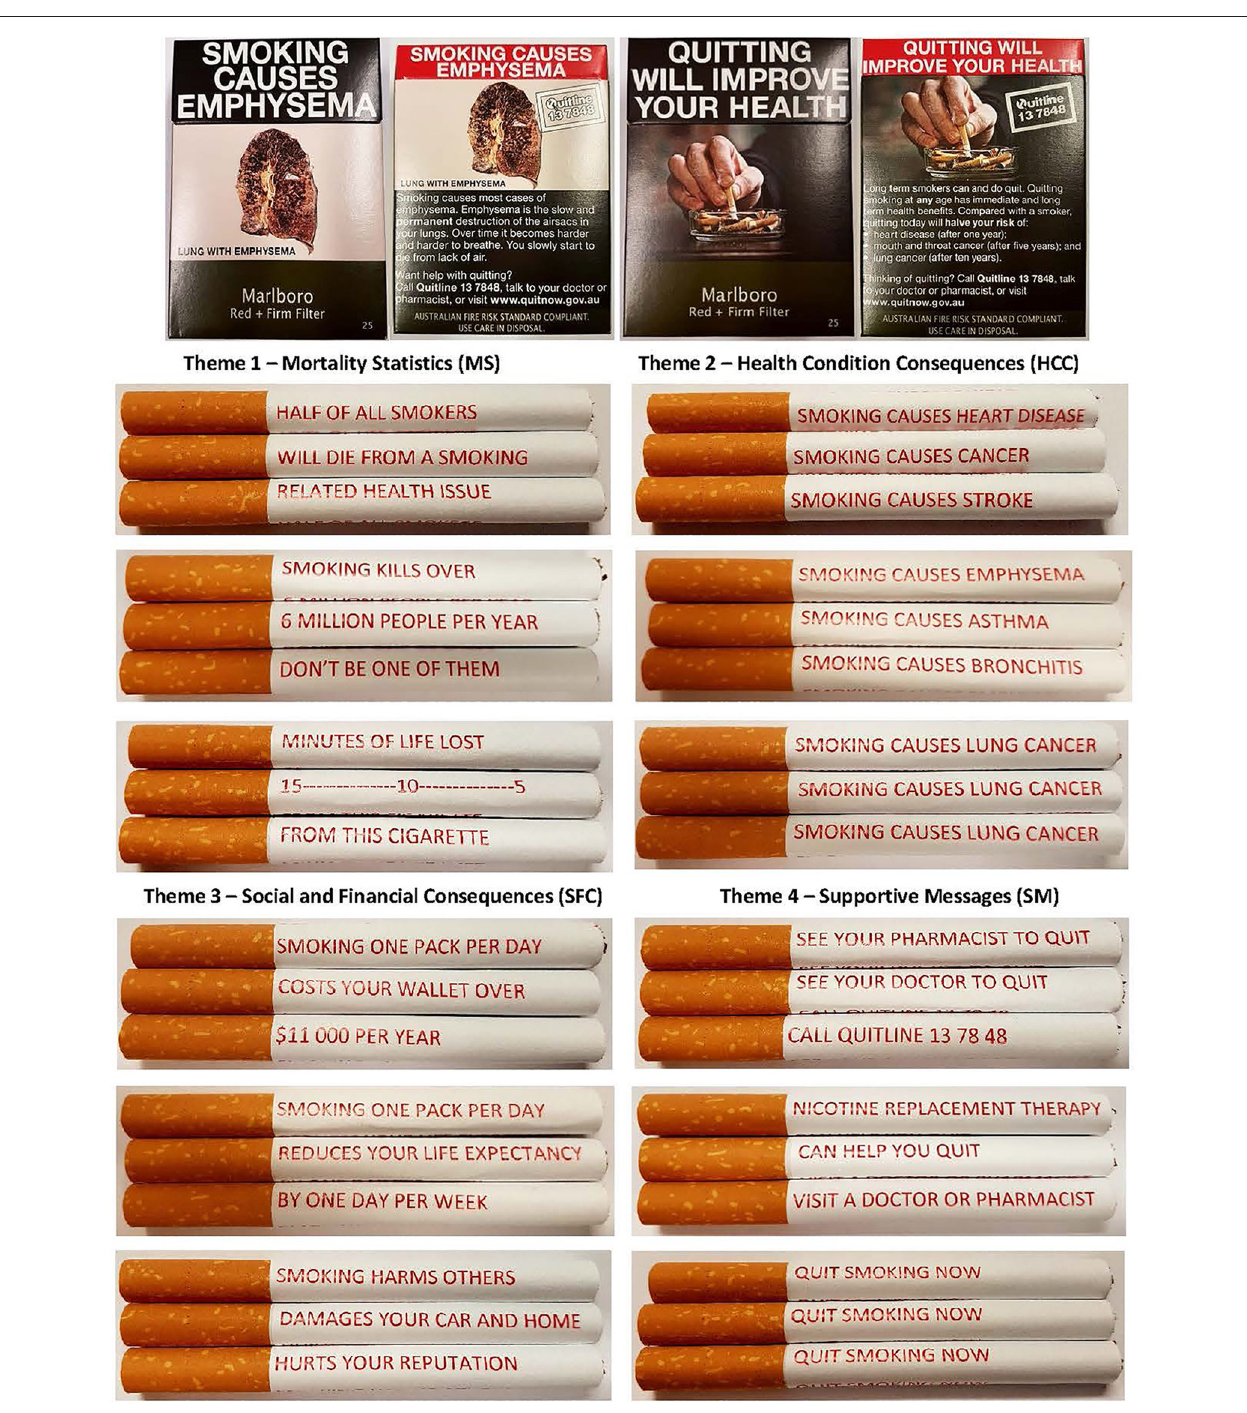
FIGURE 1 | The front and back of two cigarette packaging in circulation in Australia, and the 12 cigarette warnings divided in to the four themes. Each cigarette includes three lines of text and is rotated to read the entire message.